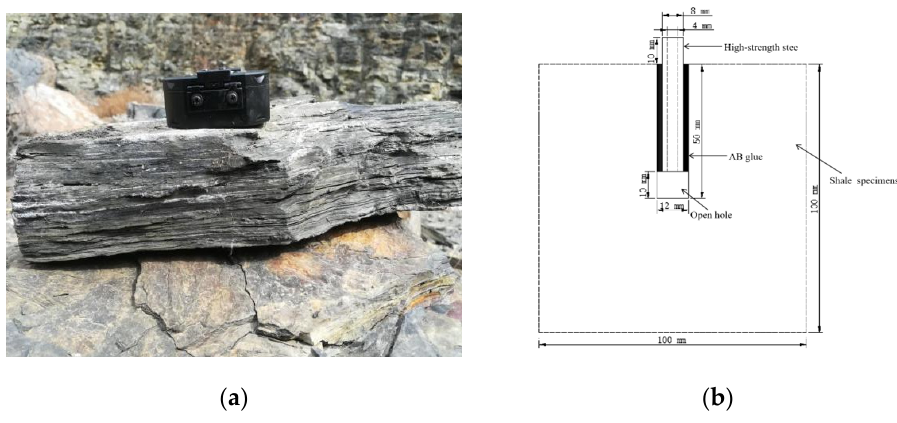
Table 1. Shale mineral composition measured by XRD.